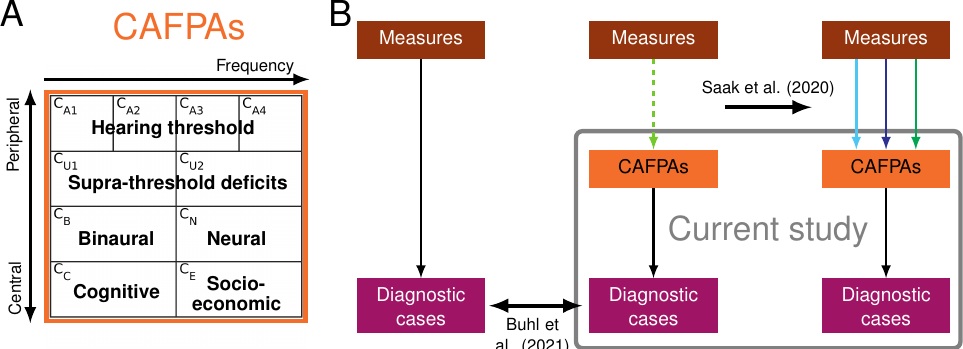
Figure 1. ( A ) Definition of CAFPAs. From left to right, increasing frequency is represented, and from top to bottom, peripheral to central aspects are represented. ( B ) Relationships between previous work and current study. Black arrows represent a classification, light green (dashed) arrows represent expert knowledge, and light blue, blue, and green arrows represent different CAFPA prediction models (lasso regression, elastic net, and random forest, respectively). Buhl et al. [32] compared classification into diagnostic cases based on measures vs. CAFPAs (left and middle part). Saak et al. [33] derived regression models for CAFPA prediction based on the expert link between measures and CAFPAs (middle and right part). The current study (grey box) investigates the application of predicted CAFPAs in the CDSS as compared to classification based on expert-estimated